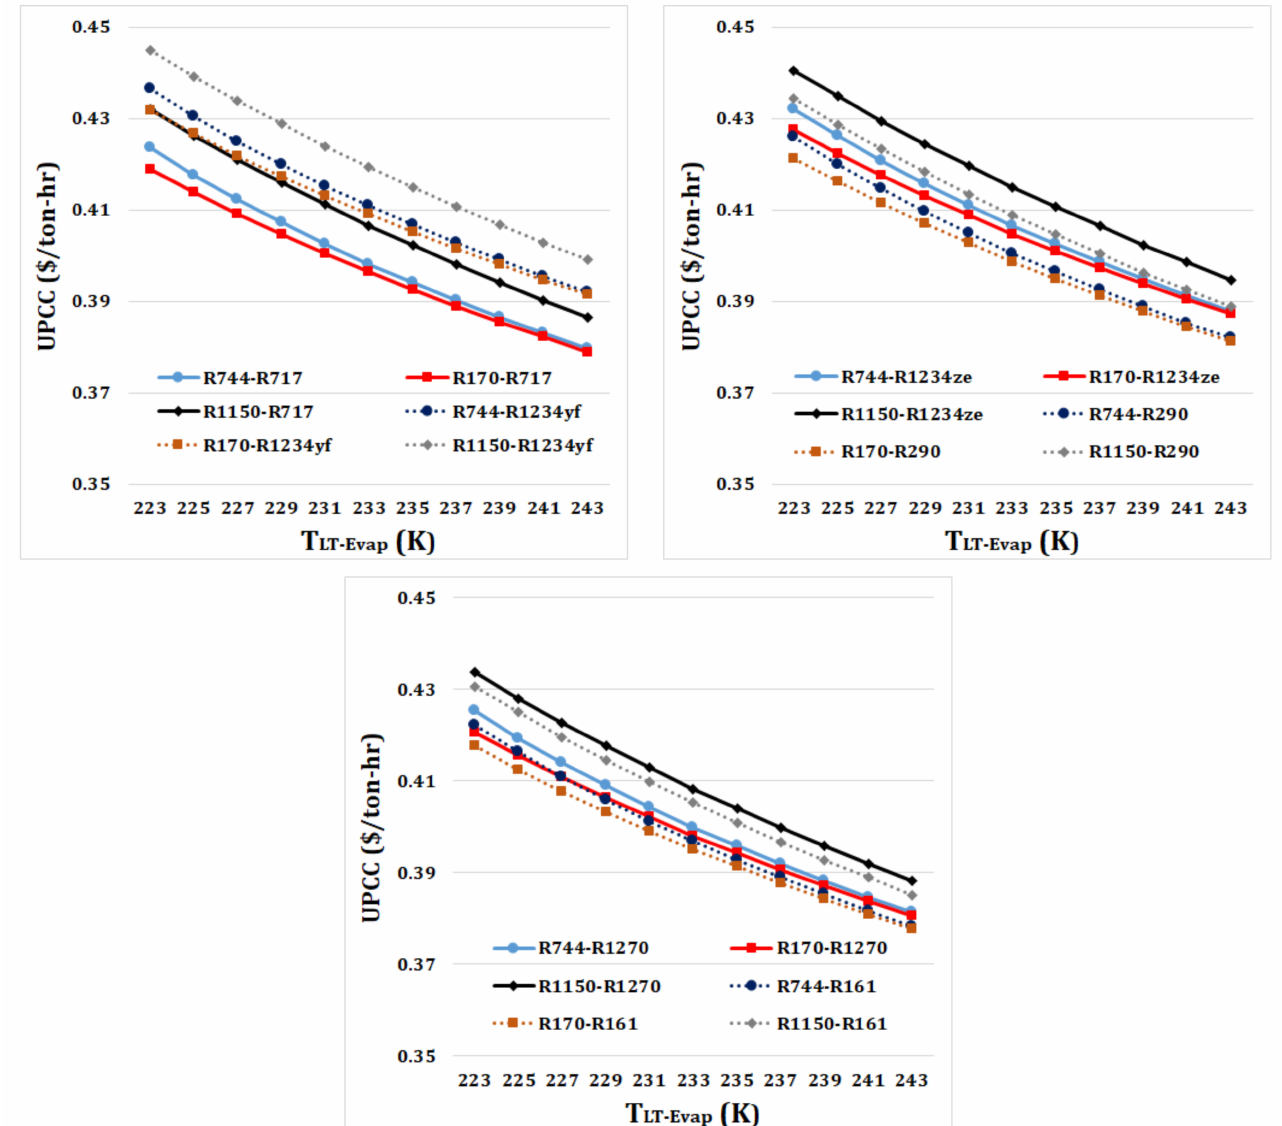
Figure 7. Effect of low-temperature evaporator ( T LT − Evap ) on the UPCC for different refrigerant pairs. As shown in Figures 7 and 9, the UPCC has a decreasing trend with an increase in both T LT − Evap and T HT − Evap . It is observed that the decreasing trend of UPCC is almost the same for all refrigerant pairs. With an increase in T LT − Evap and T HT − Evap , the AOC of the refrigeration cycle decreases mostly because of an increase in the COP. Also, the ACC decreases because of a decrease in the size of components, especially the compressors. The decrease of both AOC and ACC causes a reduction in the UPCC of the cascade refrigeration cycle. According to Figures 7 and 9, the lowest values of UPCC are obtained when